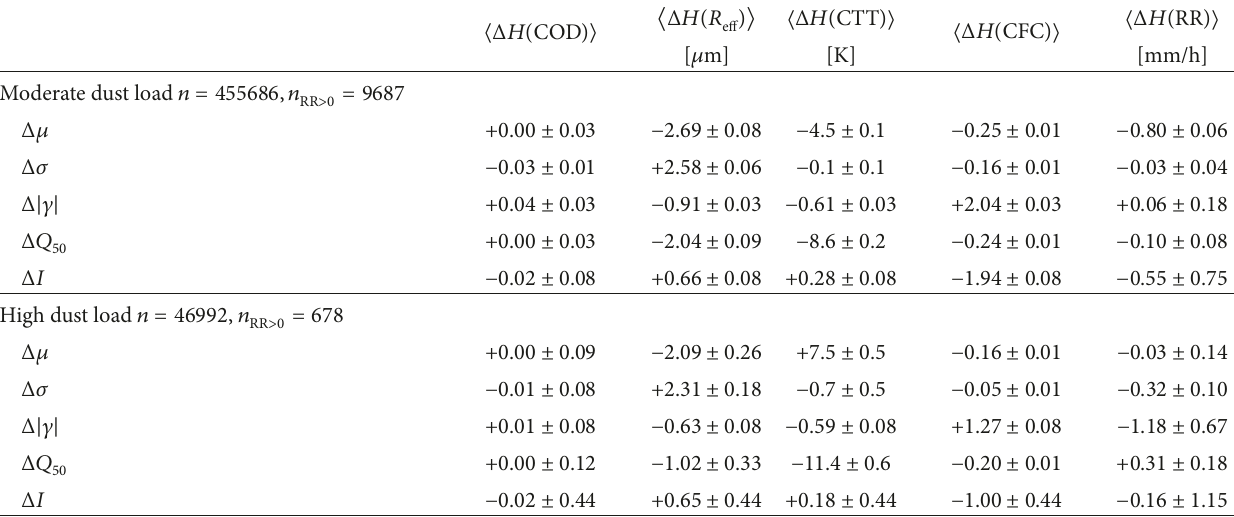
Table 2: Deviation statistics for four cloud variables COD, 𝑅 IWP has been used to describe the meteorological